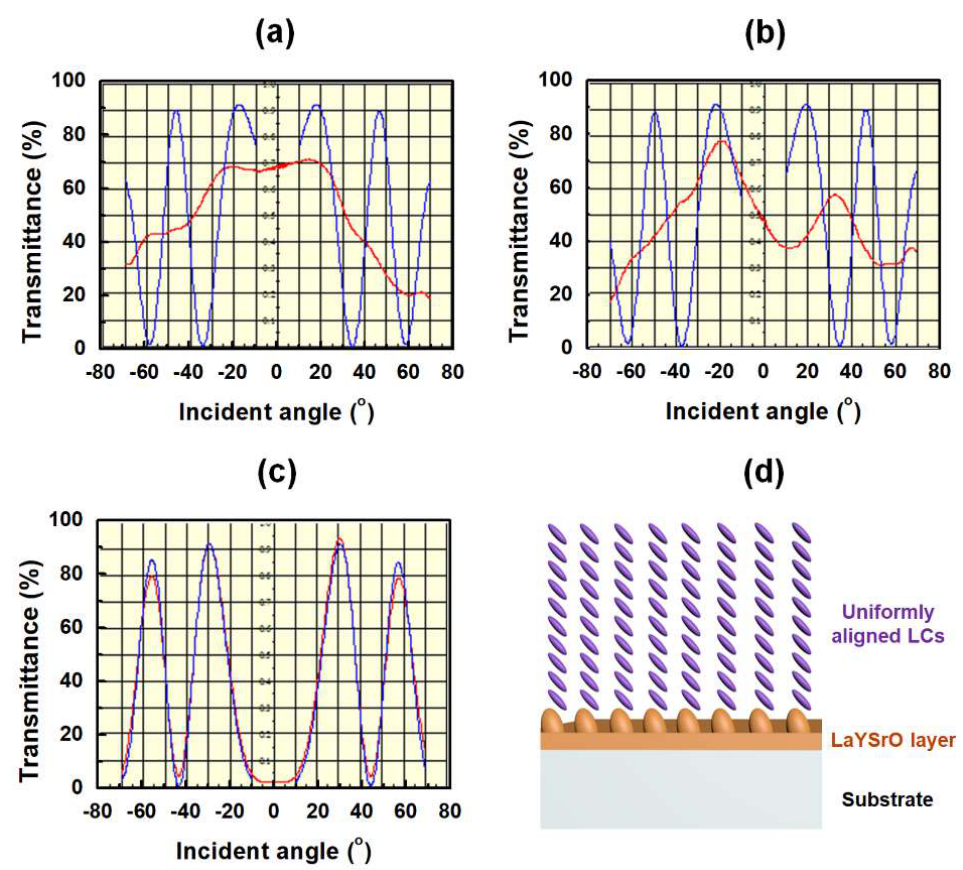
Figure 6. Optical transmittance graphs of the AP-LC cells fabricated from brush-coated LaYSrO films cured at ( a ) 70 ◦ C, ( b ) 170 ◦ C, and ( c ) 270 ◦ C. The graphs are obtained by latitudinal rotation from − 70 ◦ to 70 ◦ using the crystal rotation method. ( d ) Illustration of uniform and homogeneous LC alignment on the oriented nano/microstructures of the constructed LaYSrO alignment layer.